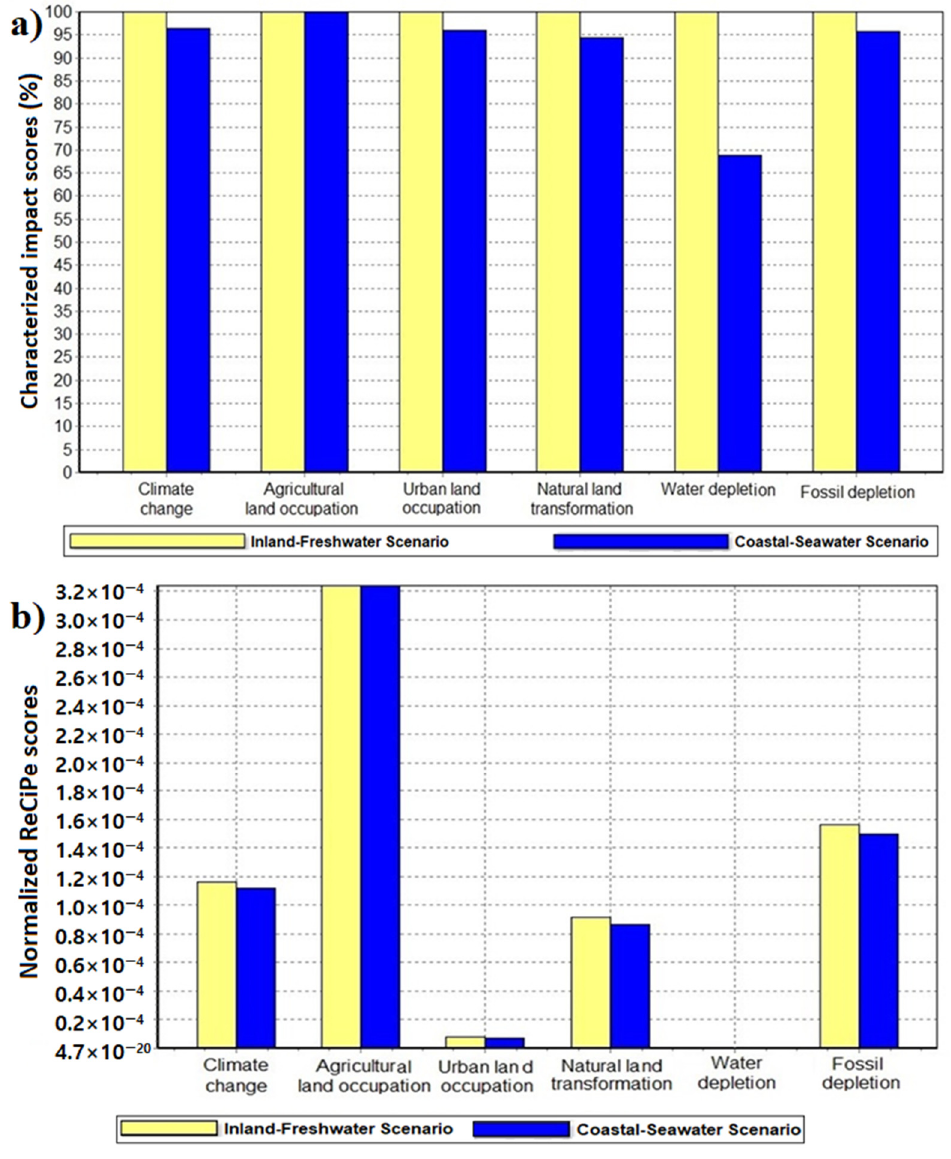
Figure 5. Comparative life cycle environmental impacts of the two scenarios of bioethanol production. ( a ) The data have been characterized for direct comparison of the scenarios in six impact categories based on ethanol (95% in solution state) from sugar beet, Alloc Def, U. ( b ) The values have been normalized for their relative significance using the ReCiPe European normalization method on